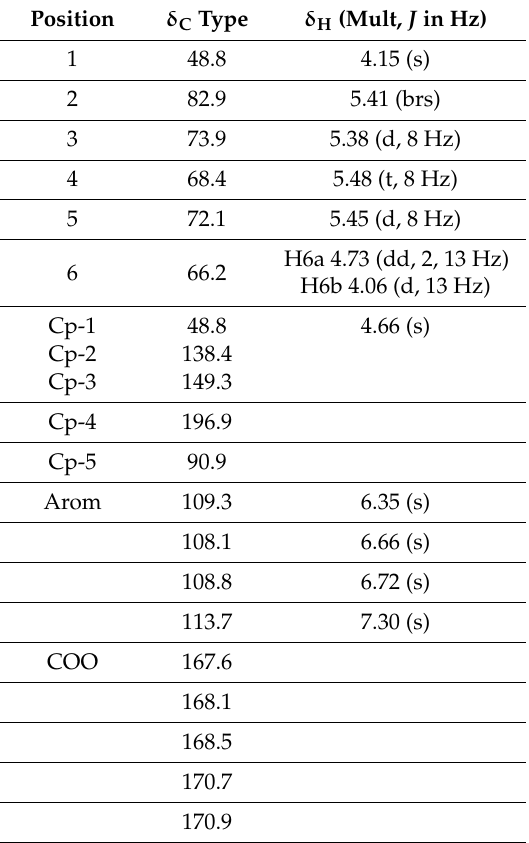
Table 1. 1H- and 13C-NMR (Carbon-13 Nuclear Magnetic Resonance assignments) for Castacrenin E. Position δ C Type δ H (Mult, J in